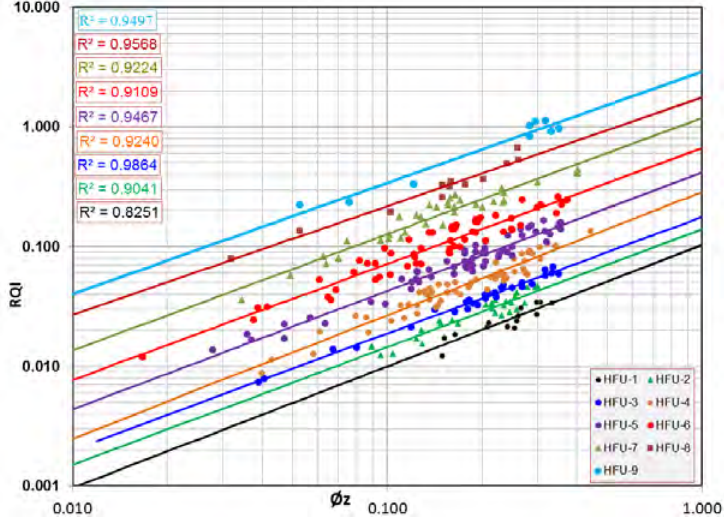
Figure 6. Hydraulic flow units of Upper Bahariya